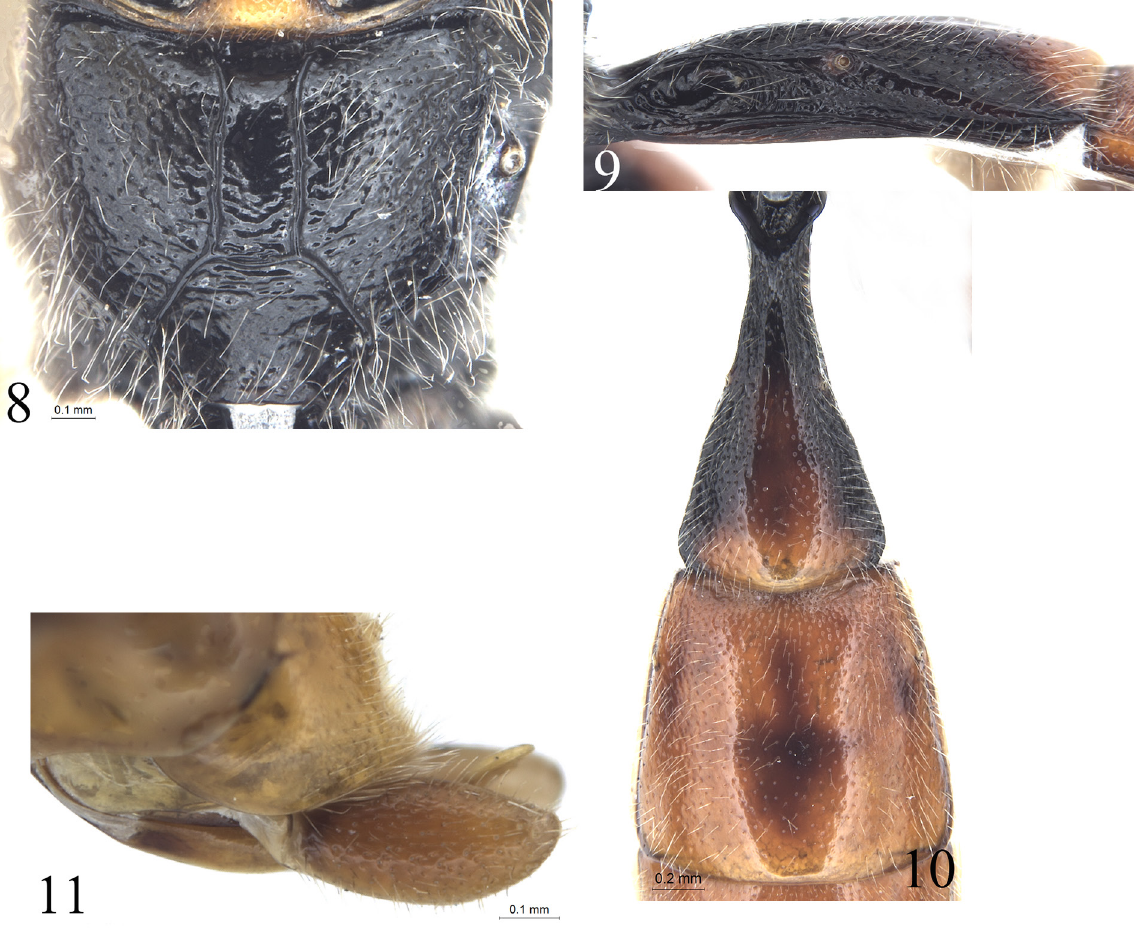
Figs 8–11. Ctenopelma labiatum Sheng, Sun & Li sp. nov., holotype, ♀ (GSFGPM). 8 . Propodeum. 9 . First tergite, lateral view. 10 . Tergites 1–2, dorsal view. 11 . Apical portion of metasoma, lateral